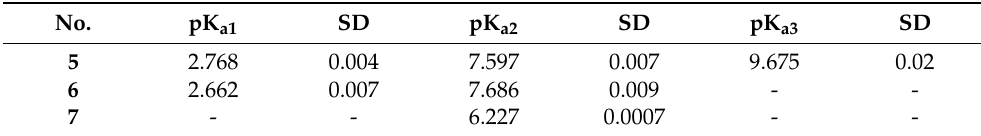
Table 2. pK a and standard deviation values determined for the selected monomer structures pre- sented in Figure